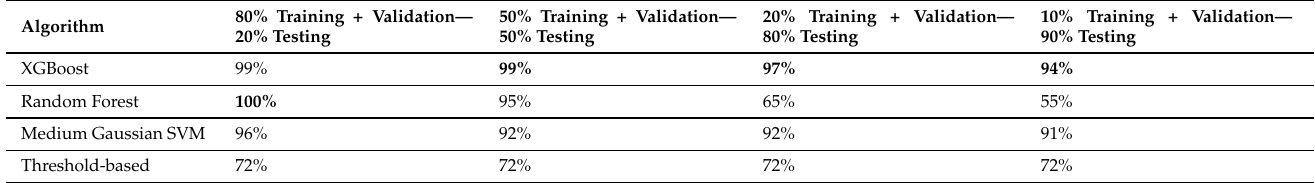
Table 8. LOS detection accuracy ([%]) with measurement data and ML approaches; threshold based- approaches are taken as a